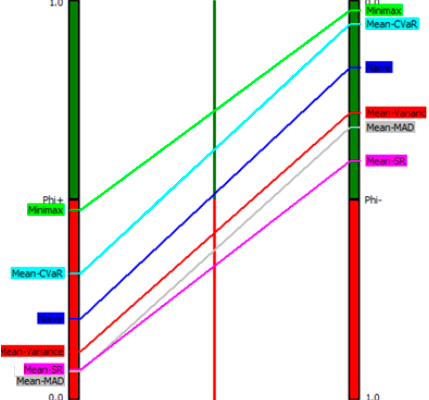
Figure 3. Diagram for partial ranking.